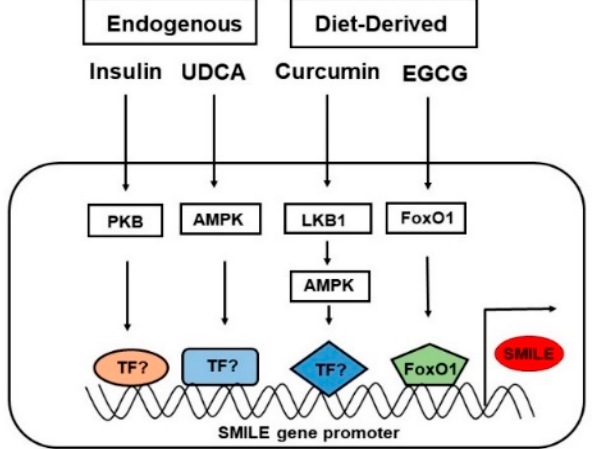
Figure 3. SMILE, an inducible transcriptional corepressor. Many inducible stimuli such as insulin, curcumin, UDCA, and EGCG are known inducible factors that activate SMILE expression via the respective pathways. The endogenous inducers insulin and UDCA mediate SMILE expression via the PKB and AMPK pathways, respectively. Diet-derived curcumin induces SMILE expression via LKB1, which in turn activates AMPK signaling. EGCG, also as a diet-derived stimulus, mediates expression via FoxO1, which acts as a known transcription factor for SMILE expression. SMILE binds to the transcription factors and inhibits the target gene expression, acting as an inducible transcription